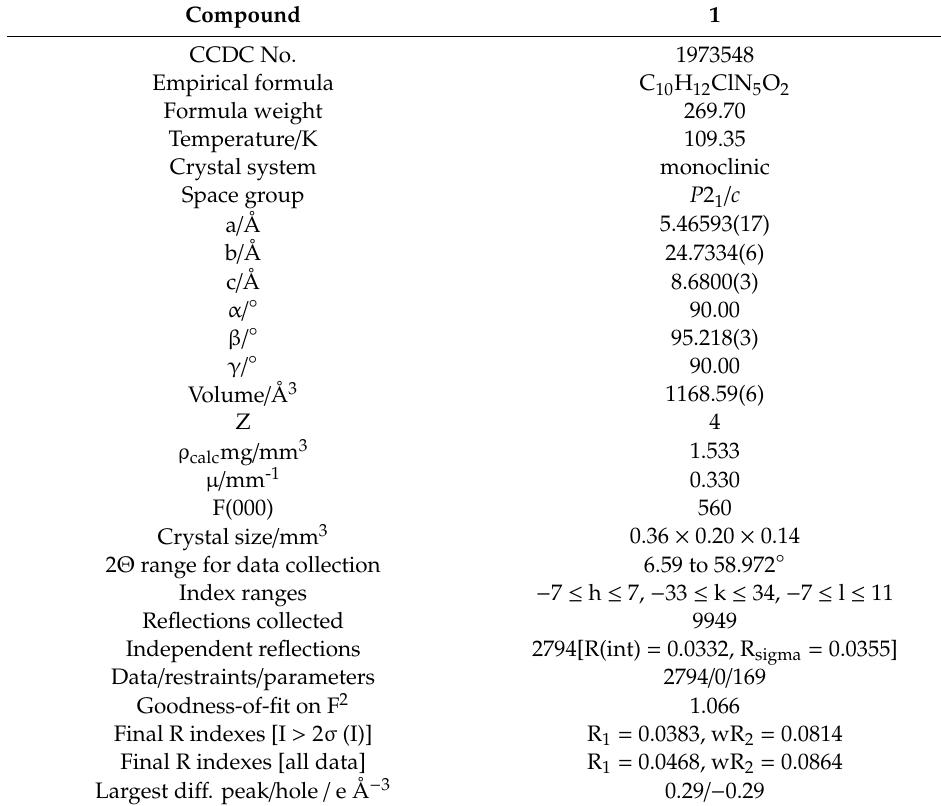
Table 1. Crystal data and structure refinement data of Compound 1